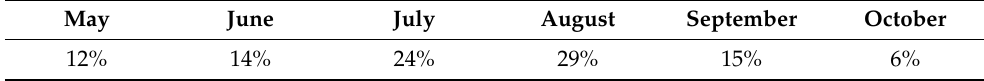
Table 1. Travel behavior of vacation home guests. Source: